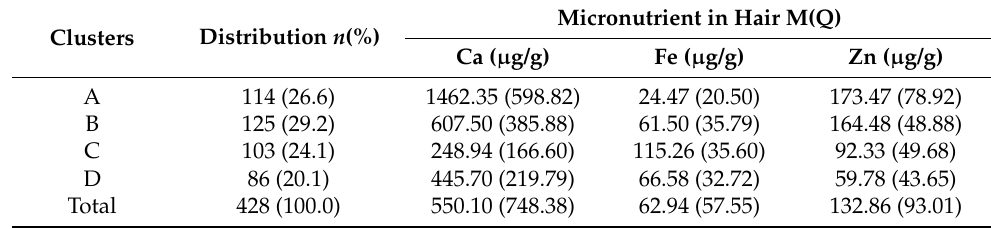
Table 3. Clusters grouped by micronutrient contents in hair.